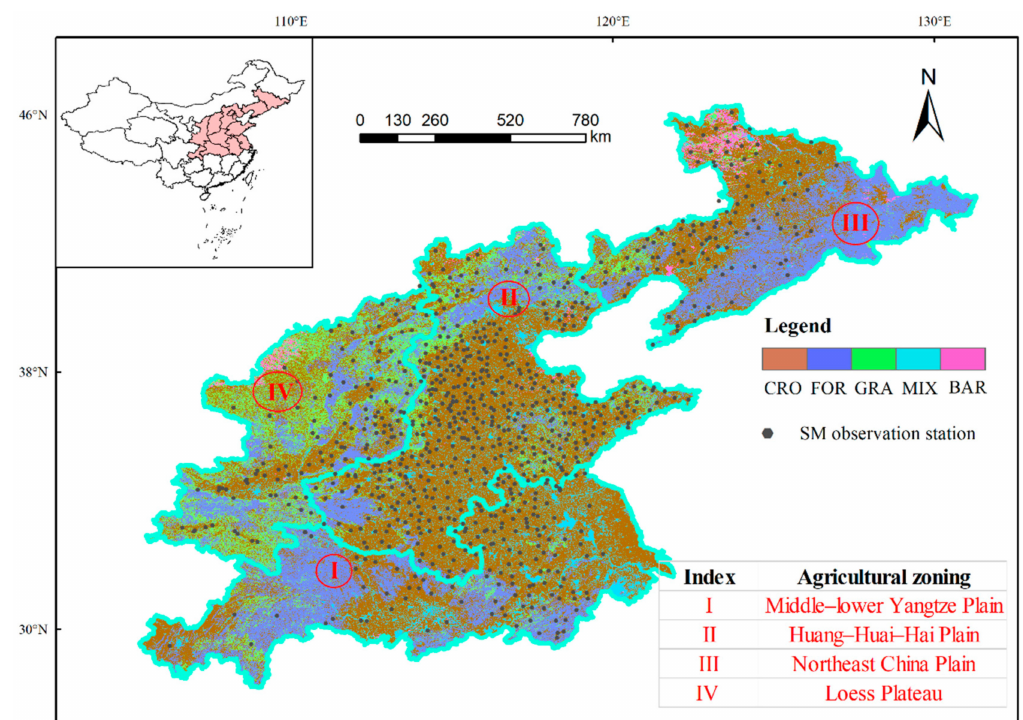
Figure 1. Locations of study area, ground SM monitoring network (black dots) and distribution of land uses (background color), together with four agricultural zoning areas (cyan lines).